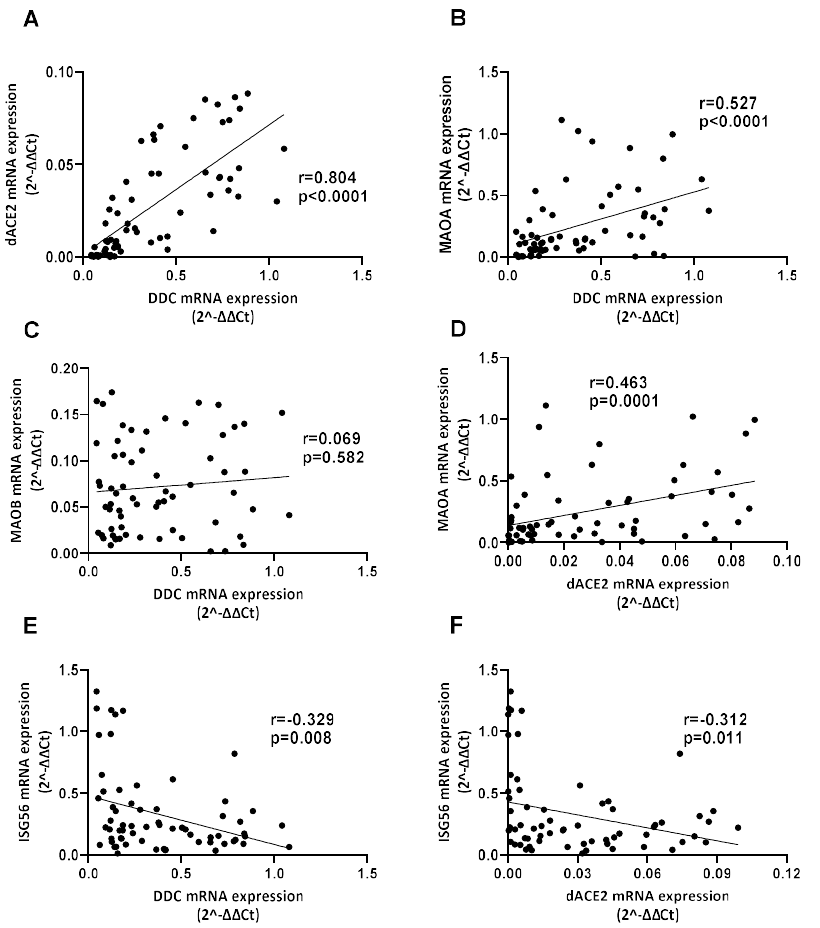
Figure 8. Correlation between the mRNA levels of ( A ) DDC-dACE2 , ( B ) DDC-MAOA , ( C ) DDC- MAOB , ( D ) dACE2-MAOA , ( E ) DDC-ISG56 and ( F ) dACE2-ISG56 in whole blood samples of hospi- talized COVID-19 patients. Data are presented as XY scatter plots and fitted linear regression lines. Pearson’s or Spearman’s correlation coefficient (r) and p -values (p) were calculated. To exclude the possibility that our results in the whole blood expression of the afore- mentioned-genes in the hospitalized COVID-19 patients are affected by the presence of comorbidities, we grouped the SARS-CoV-2 infected subjects according to the presence of underlying diseases. Our results showed that the mRNA levels of the catecholamine path- way-related genes ( DDC , MAOA , and MAOB ) were not affected (Figure S12A–C) by the presence of comorbidities, while dACE2 expression was negatively affected ( p = 0.0083) (Figure S12D). Thus, the observed alterations in the whole blood expression of the cate- cholamine biosynthesis/metabolism genes in hospitalized COVID-19 patients are due to SARS-CoV-2 infection. 3.7. The effect of SARS-CoV-2 Infection on Catecholamine Pathway-Related Gene Expression in Cultured Epithelial Cells